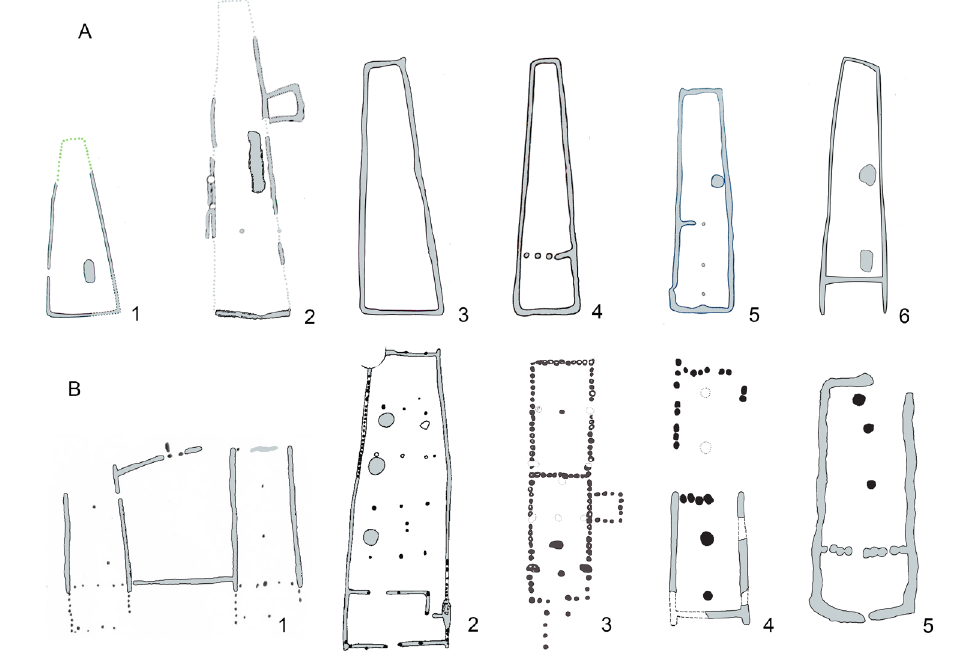
Fig. 7. A. Examples of BKK houses from different parts of the Polish Lowlands:1- Konary 1, house 6; 2- Bodzia 1, house 4; 3- Konary 1, house 2; 4- Brześć Kuj. 4, house 56; 5- Pikutkowo 6A, house 1; 6- Dubielewo 8. After: Grygiel 2008 (1, 3-5);